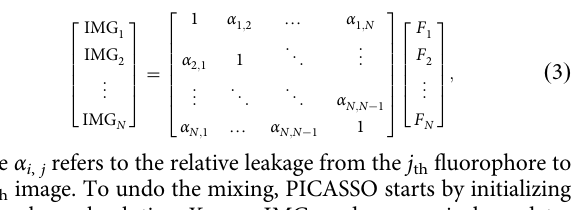
Fig. 1 Schematic of the PICASSO process. a – c Experimental process of multiplexed immuno fl uorescence imaging using PICASSO. a Simultaneous immunostaining of more than 15 proteins with primary antibody – Fab complexes conjugated with spectrally overlapping fl uorophores. b Acquisition of images at different detection channels. The number of required images equals the number of fl uorophores to be unmixed. For each of the k excitation lasers, N spectrally overlapping fl uorophores are used, making the total number of fl uorophores k × N . c Blind source separation of N mixed images into N images, each of which contains the signal from only one fl uorophore through progressive mutual information (MI) minimization. d Emission spectra of two spectrally overlapping fl uorophores (green and magenta solid lines and colored regions) and detection channels (green and magenta dotted boxes). Here α is the ratio of the area with horizontal dotted lines to the area with vertical dotted lines. IMG1, 2 are images acquired at the fi rst (green dotted box) and second (magenta dotted box) detection channels. e Emission spectra of N spectrally overlapping fl uorophores and detection channels. f , g Schematic of the PICASSO unmixing algorithm. The images are unmixed by progressively minimizing the MI between mixed images. f N -color unmixing via MI minimization. g Two-color unmixing via MI minimization. Q = quantization, X ’ and Y ’ = quantized IMG1, 2. I ( X ’ ; Y ’ − α 21 X ’ ) = MI between X ’ and Y ’ − α 21 X ’ . I ( Y ’ ; X ’ −